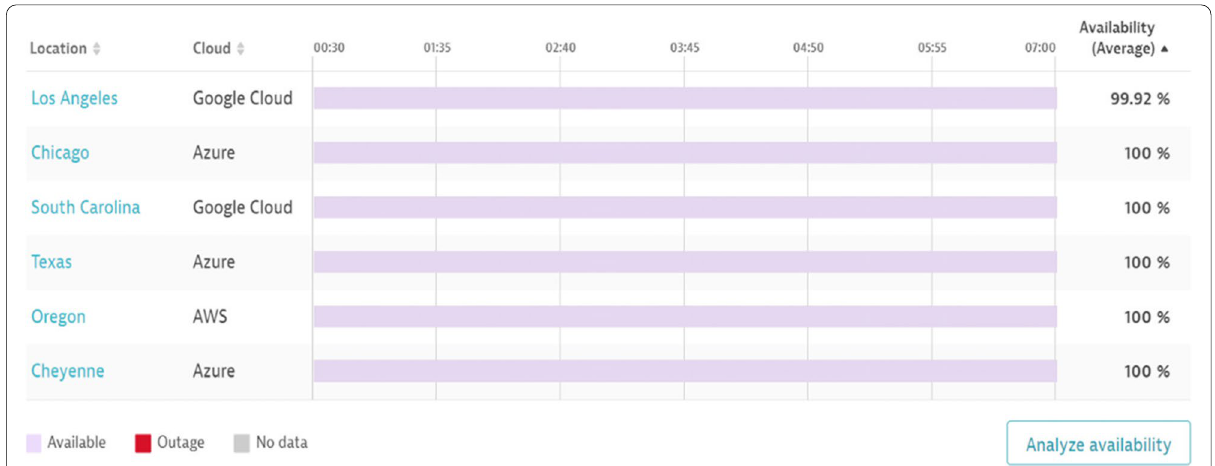
Fig. 22 Application availability split by geography of synthetic tests